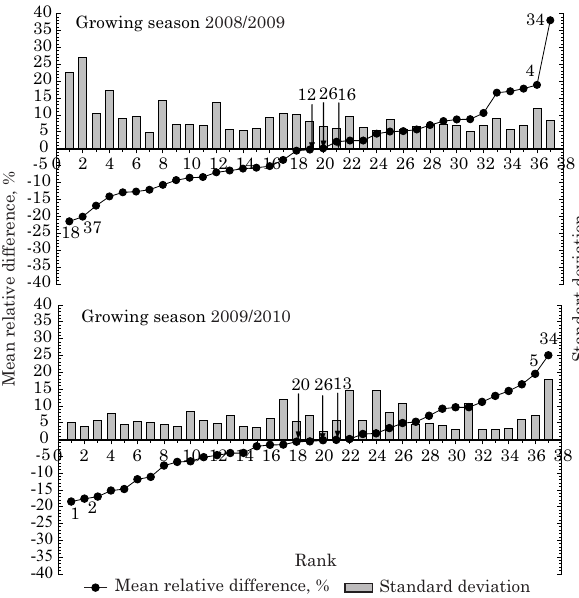
Figure 7. Mean relative difference and standard deviation of the average water storage, in the layer 0.00-0.30 m, in grapevine rows on a